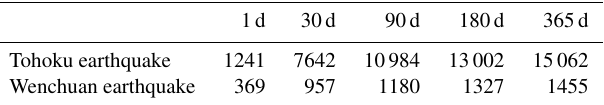
Table 1. The number of aftershocks of typical historical earthquakes on multiple